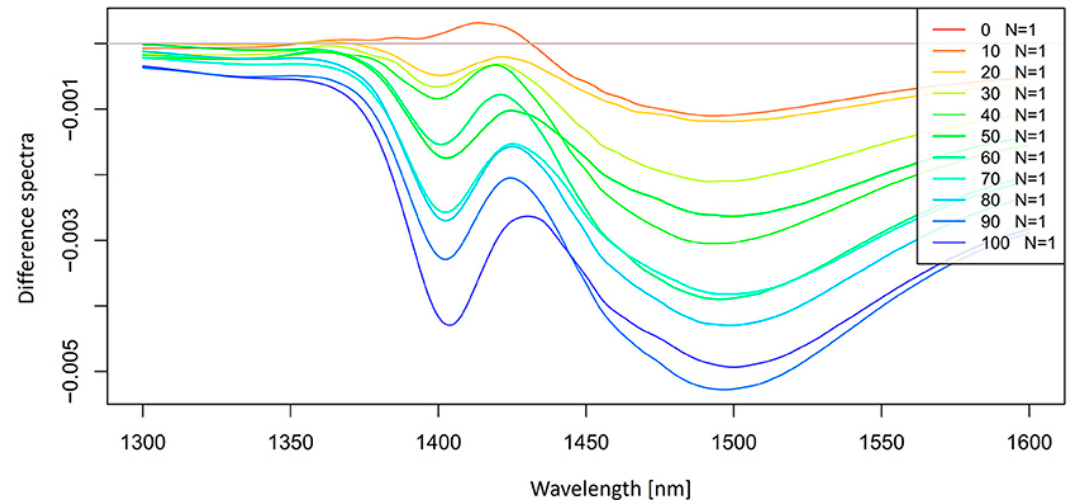
Figure 4. Difference absorbance spectra in the spectral range of 1300–1600 nm (OH first overtone) of pure water and aqueous solutions of potassium-chloride in the concentration range of 10–100 mM. The average spectrum of pure water was subtracted from the spectra of potassium-chloride solutions. 6